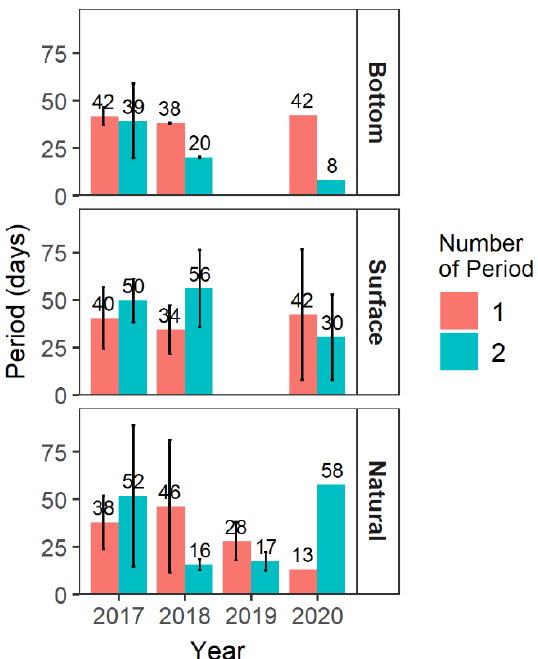
Figure 6. Average periods with standard deviation calculated from the multi-frequential periodogram analysis at frequencies 1 and 2 for the 24 sites (8 Bottom, 8 Surface, 8 Natural) and years meeting the required water management conditions.